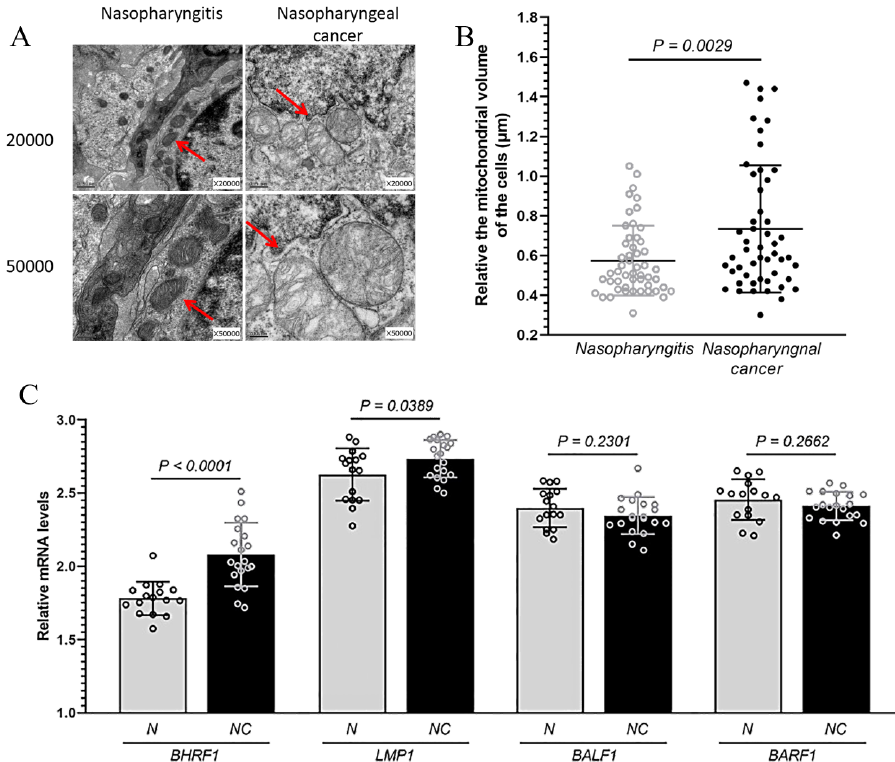
Figure1. ThechangesinmitochondrialmorphologyandEBVencodedproteinsinNPC.Nasopharyngeal carcinoma (NPC) and nasopharyngitis are two common pathological changes in nasopharynx. ( A ), Mitochondrial morphology analyzed under transmission electron microscopy in the tissue of patients with NPC and nasopharyngitis at × 20,000 and × 50,000. Mitochondria are indicated by arrows. ( B ), The relative volume of about 50 mitochondria each in the tissue of patients with NPC and nasopharyngitis. Mitochondrial size was measured using Image J by manually tracing outlines of mitochondria on TEM micrographs. ( C ), Levels of BHRF1, LMP1, BALF1 and BARF1 mRNA expression from 20 NPC (NC) and 16 nasopharyngitis (N) patients detected via